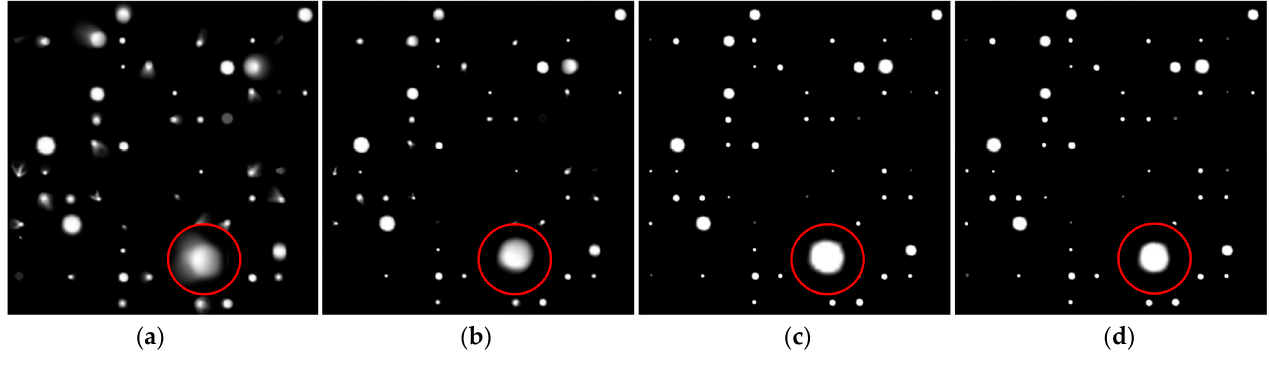
Figure 9. ( a ) Original images; ( b ) images restored when using SGD; ( c ) images restored when using Adagrad; ( d ) images restored when using Adagrad + SGD.